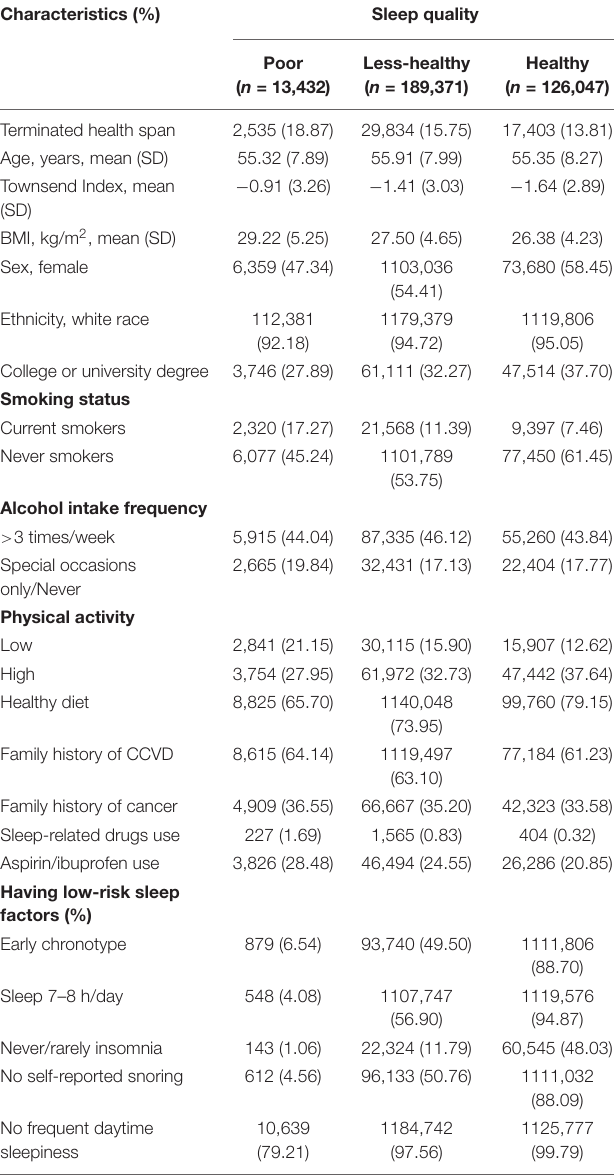
TABLE 1 | Baseline characteristics of 328,850 participants according to sleep